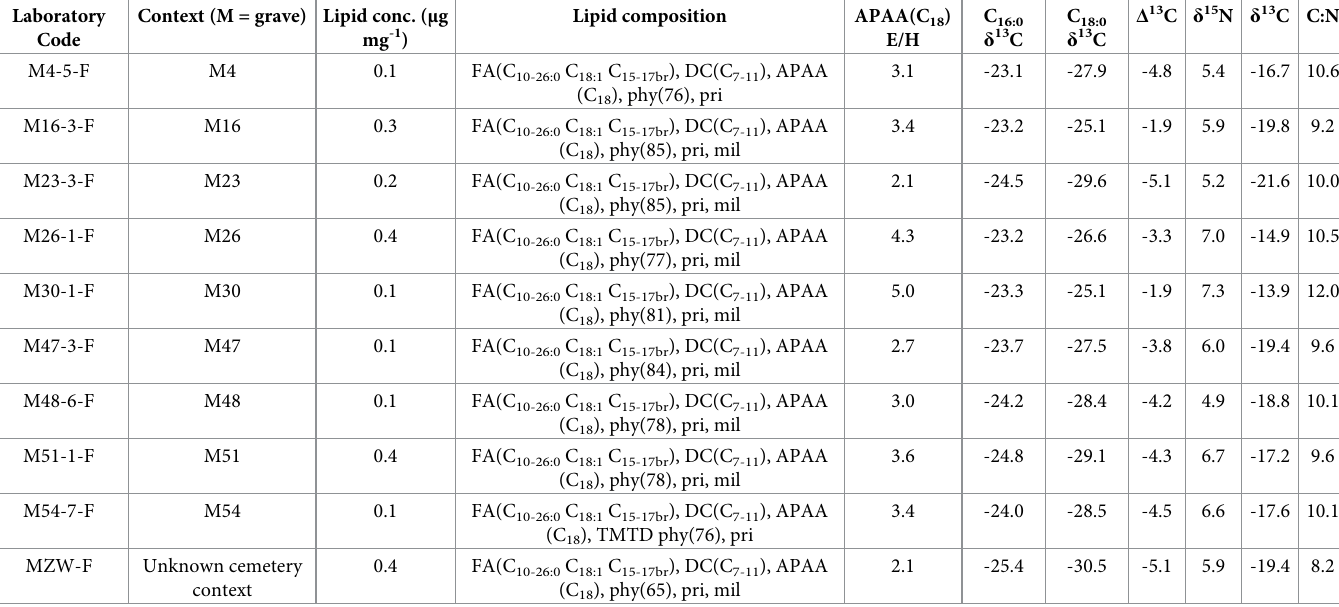
Table 2. Results of organic residue analysis of ten pottery sherds from the Zhanqi cemetery in China’s Gansu Province. Laboratory Context (M = grave) Lipid conc. ( μ g Code mg -1